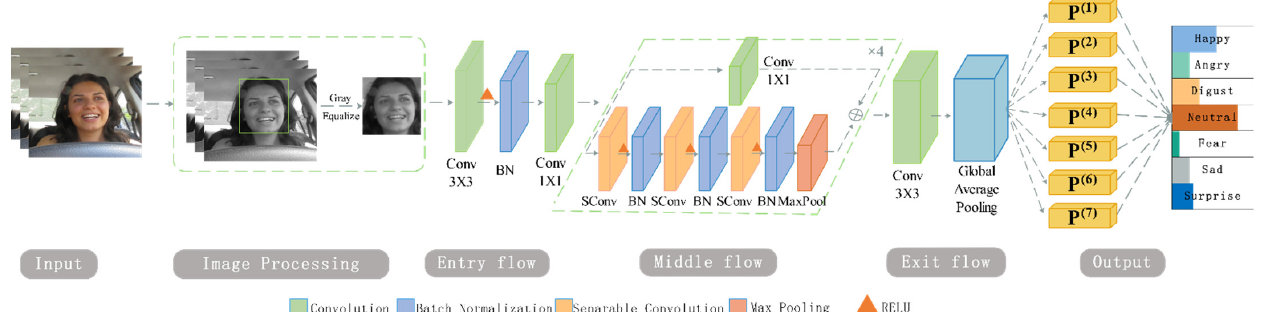
Figure 9. RM-Xception network structure diagram.